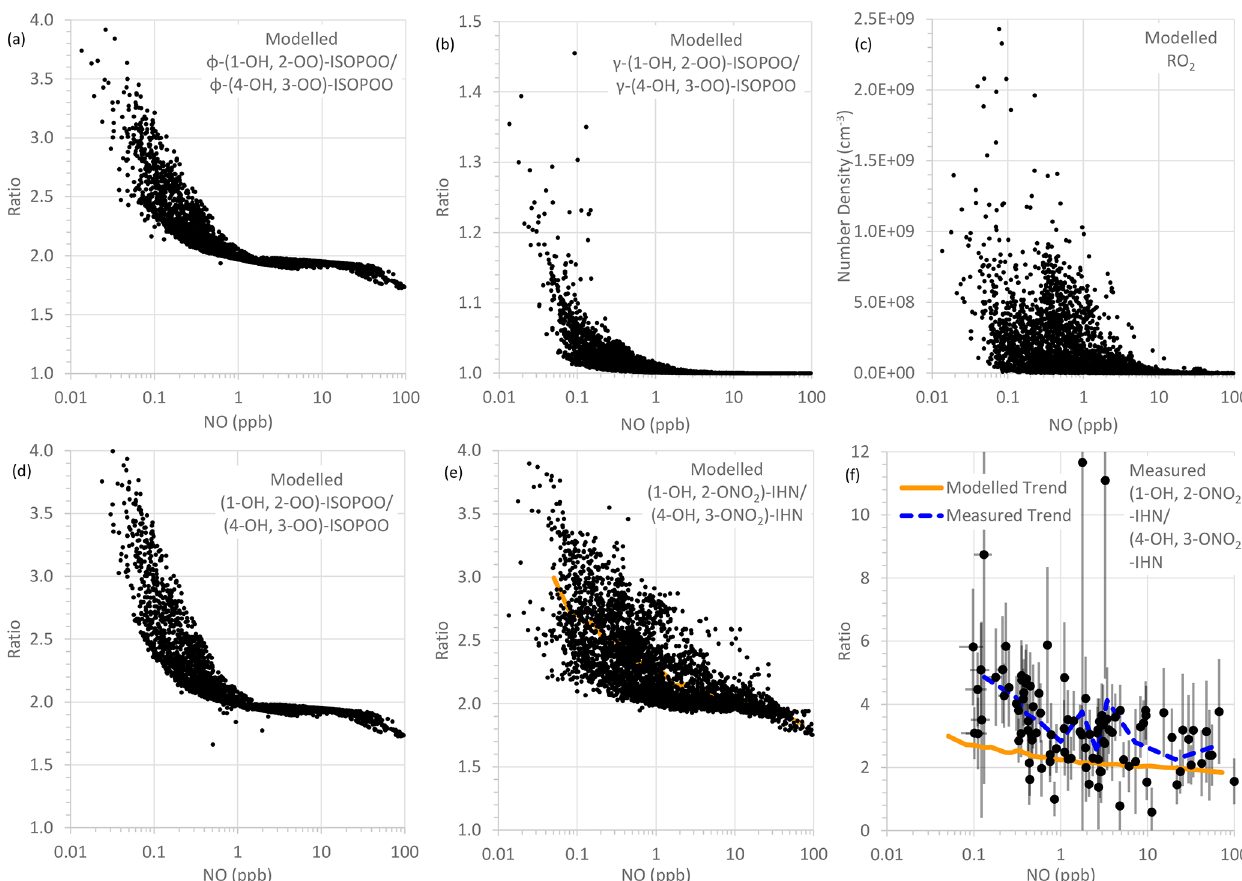
Figure 6. Modelled and measured parameters as a function of NO mixing ratio: (a) modelled ratio of ϕ -(1-OH, 2-OO)-ISOPOO to ϕ -(4- OH, 3-OO)-ISOPOO, (b) modelled ratio of γ -(1-OH, 2-OO)-ISOPOO to γ -(4-OH, 3-OO)-ISOPOO, (c) modelled RO 2 number density, (d) modelled ratio of (1-OH, 2-OO)-ISOPOO to (4-OH, 3-OO)-ISOPOO, (e) modelled ratio of (1-OH, 2-ONO 2 )-IHN to (4-OH, 3-ONO 2 )- IHN, and (f) measured ratio of (1-OH, 2-ONO 2 )-IHN to (4-OH, 3-ONO 2 )-IHN (error bars are the measurement uncertainties; see Sect. 3.3 for details). In panel (e) , the orange line is a trend line produced by plotting the mean modelled (1-OH, 2-ONO 2 )-IHN to (4-OH, 3-ONO 2 )- IHN ratio for each bin of 100 NO mixing ratios. This same line is plotted in panel (f) for comparison with the observed data. The dashed blue line in panel (f) is a trend line produced by plotting the mean measured (1-OH, 2-ONO 2 )-IHN to (4-OH, 3-ONO 2 )-IHN ratio for each bin of nine NO mixing